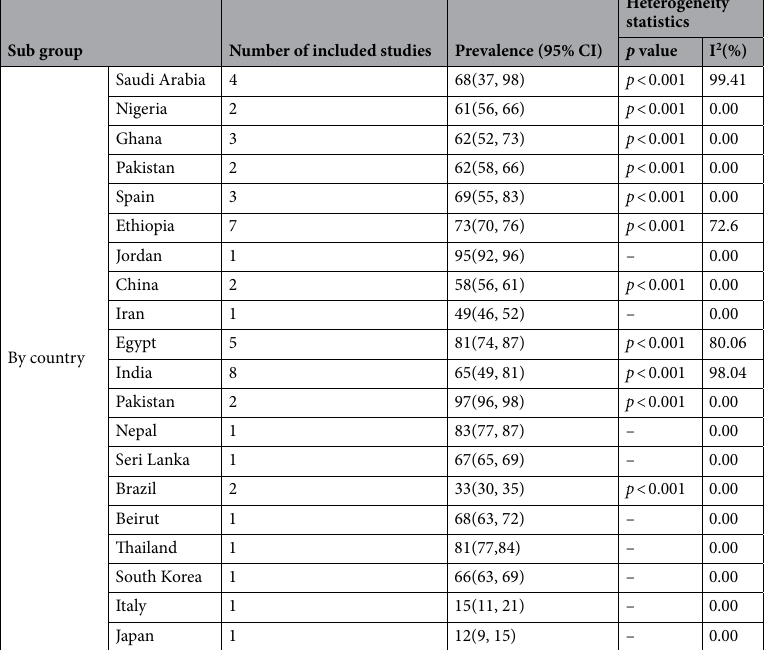
Table 2. Subgroup analysis by country on computer vision syndrome,